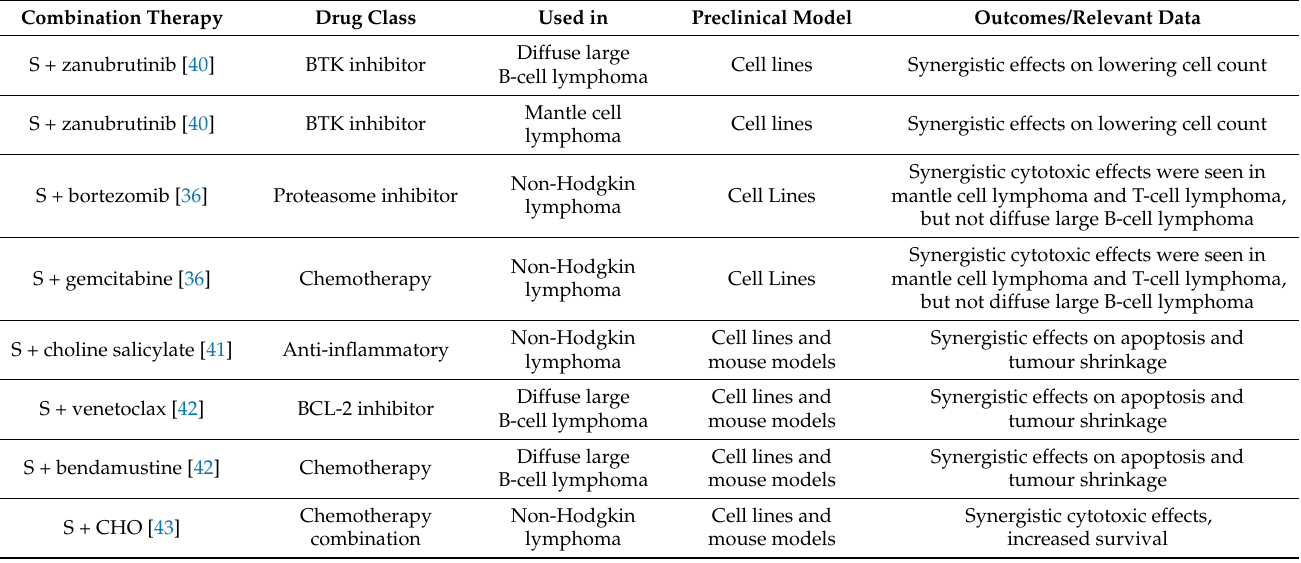
Table 3. Combination Therapies Tested Preclinically for Selinexor (S) in Non-Hodgkin